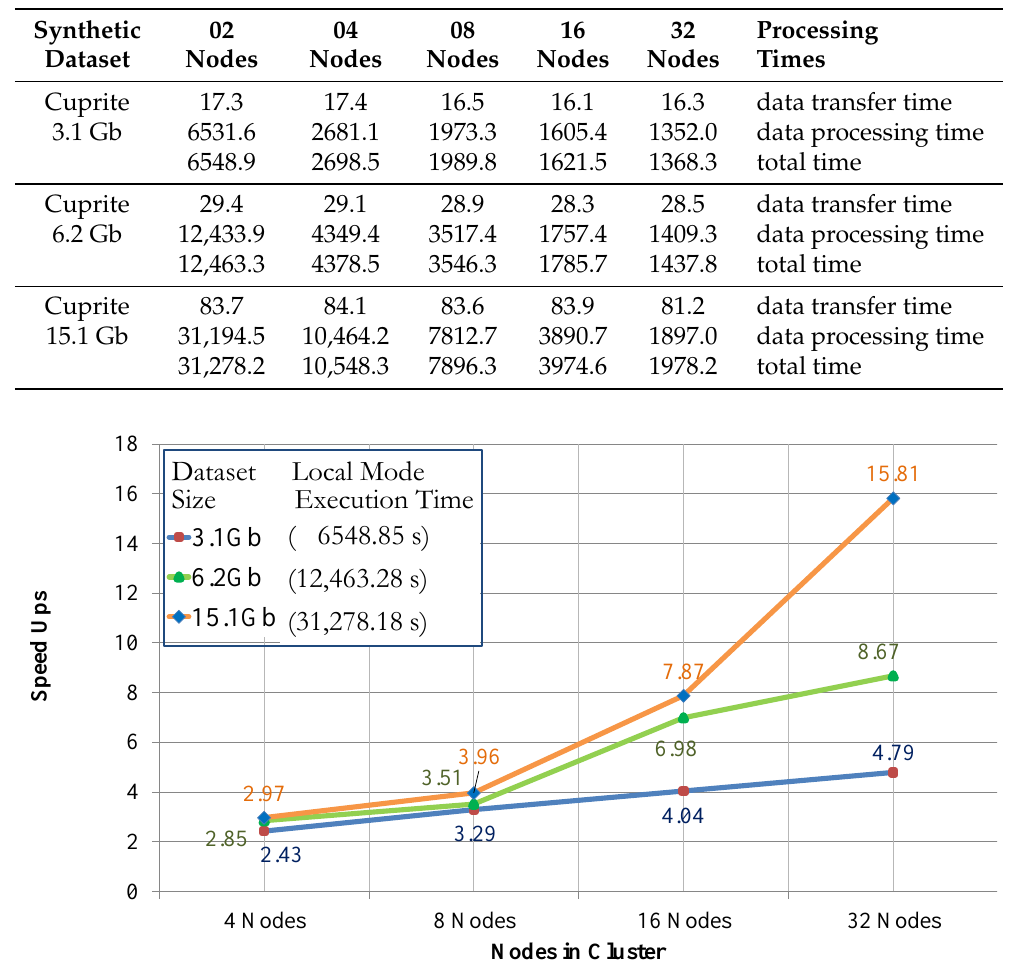
Figure 7. Speedups for the Distributed N-FINDR algorithm on the Cuprite synthetic